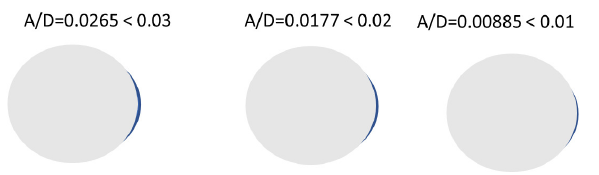
Figure 2. The new luminous crescent ratios (in